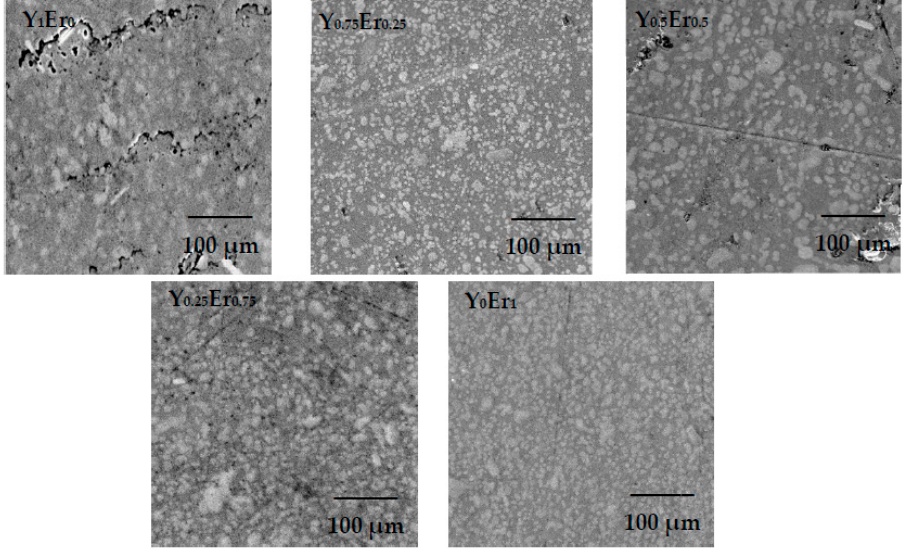
Figure 4. Micrographs at a magnification of 1000 × for the YBCO single grain observed at equivalent positions.